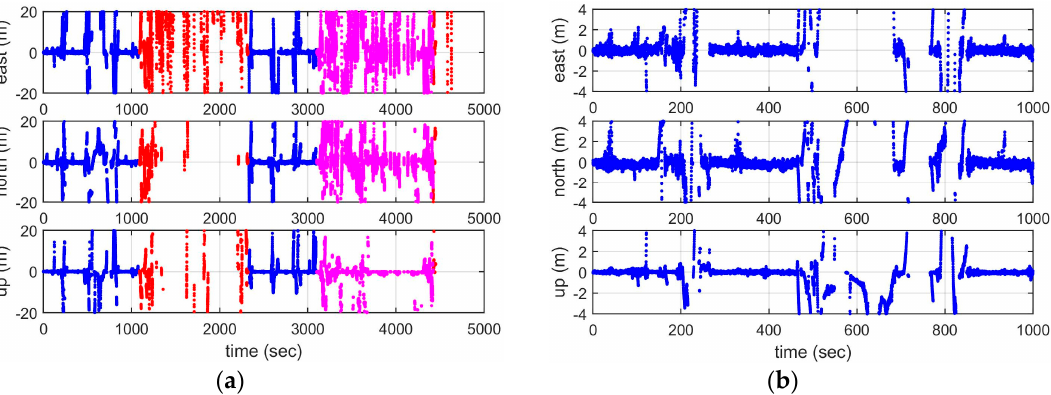
Figure 11. Positioning errors using raw code pseudorange measurements: ( a ) whole experiment, ( b ) the first 17 minutes.